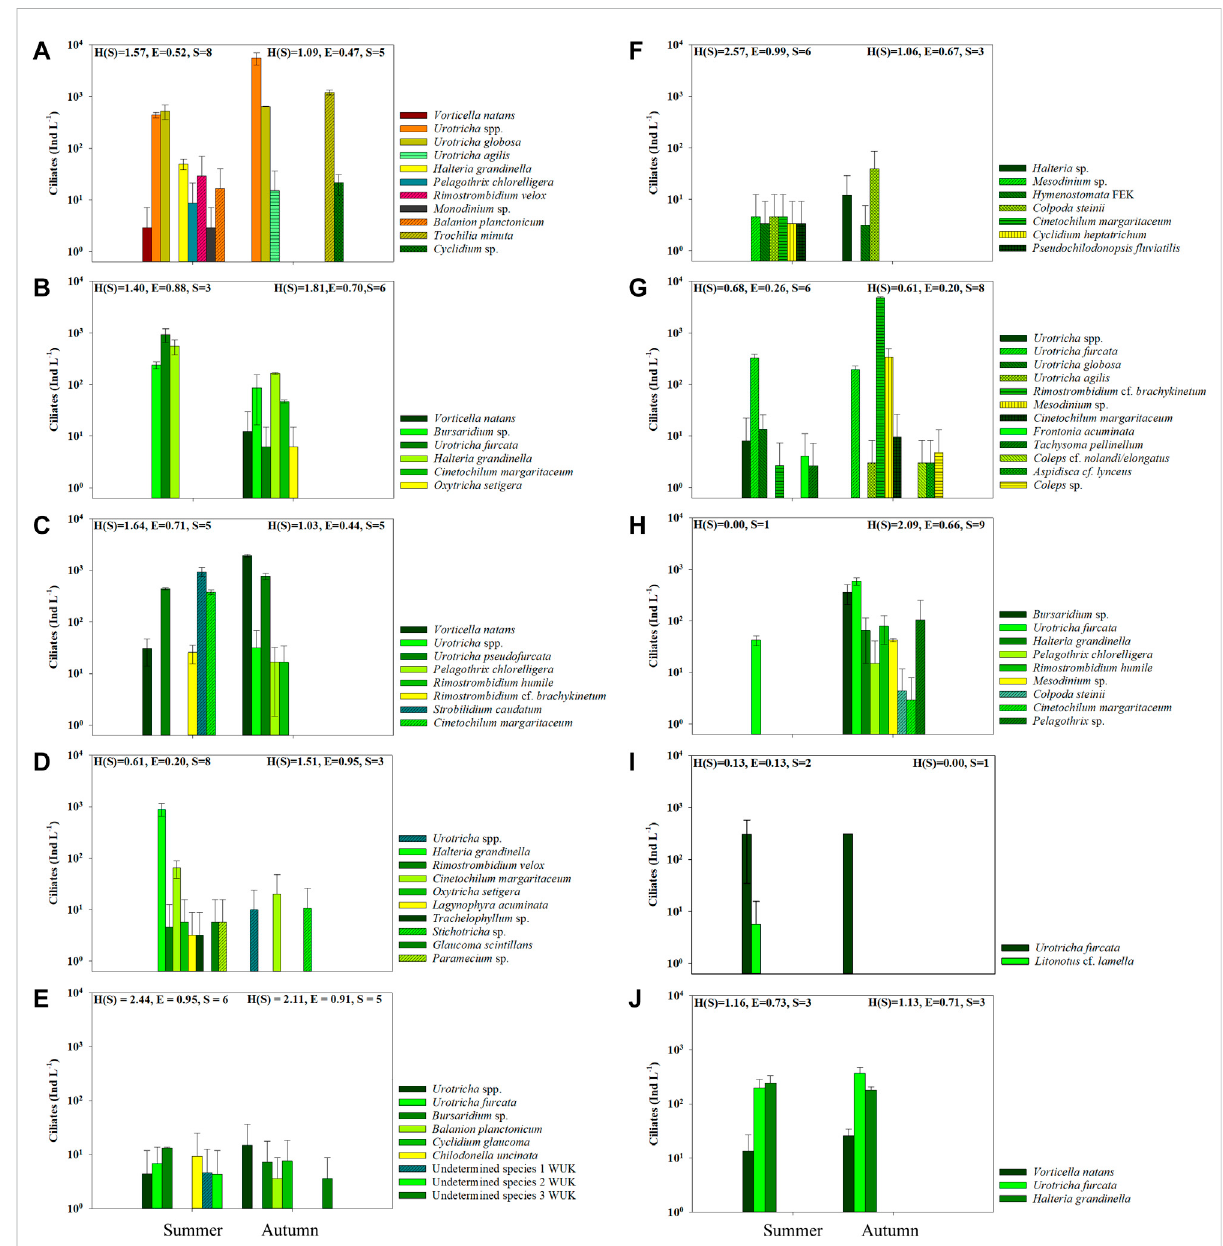
FIGURE 3 Ciliateabundance(mean±std)duringsummerandautumnsamplinginthemountainreservoirs (A) PAN, (B) FER, (C) ROK, (D) GAM, (E) WUK, (F) FEK, (G) SNJ, (H) FRO, (I) MBF, and (J) SWH. For reservoir codes see Table